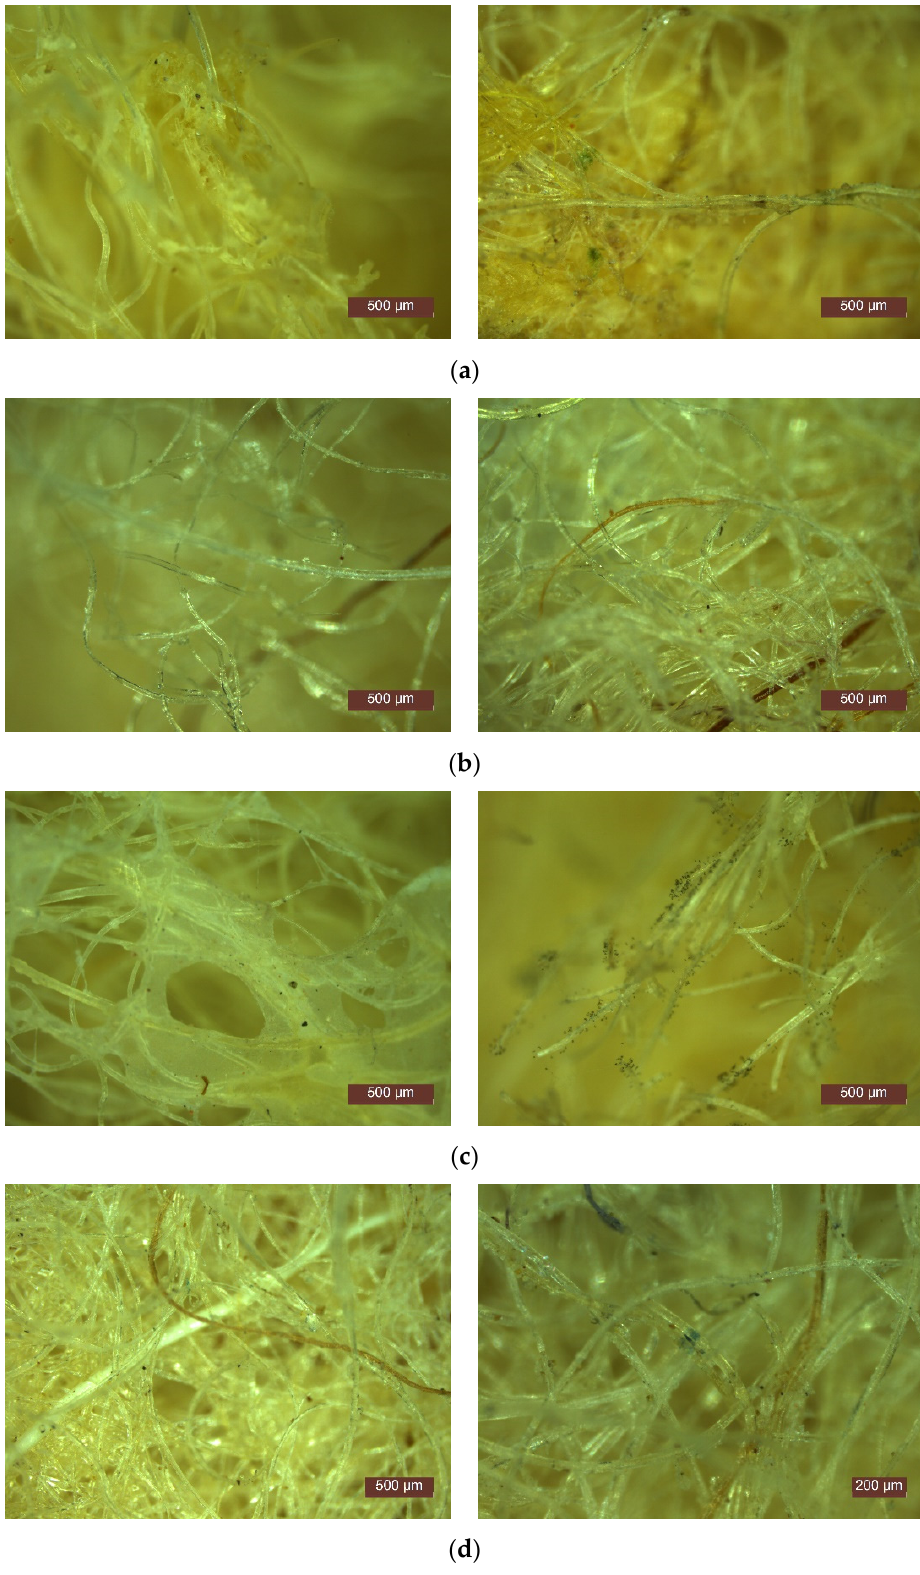
Figure 17. Growth of microorganisms identified on samples: ( a ) P3 after 4 weeks; ( b ) P13 after 4 weeks; ( c ) P3 after 6 weeks; ( d ) P13 after 6 weeks.